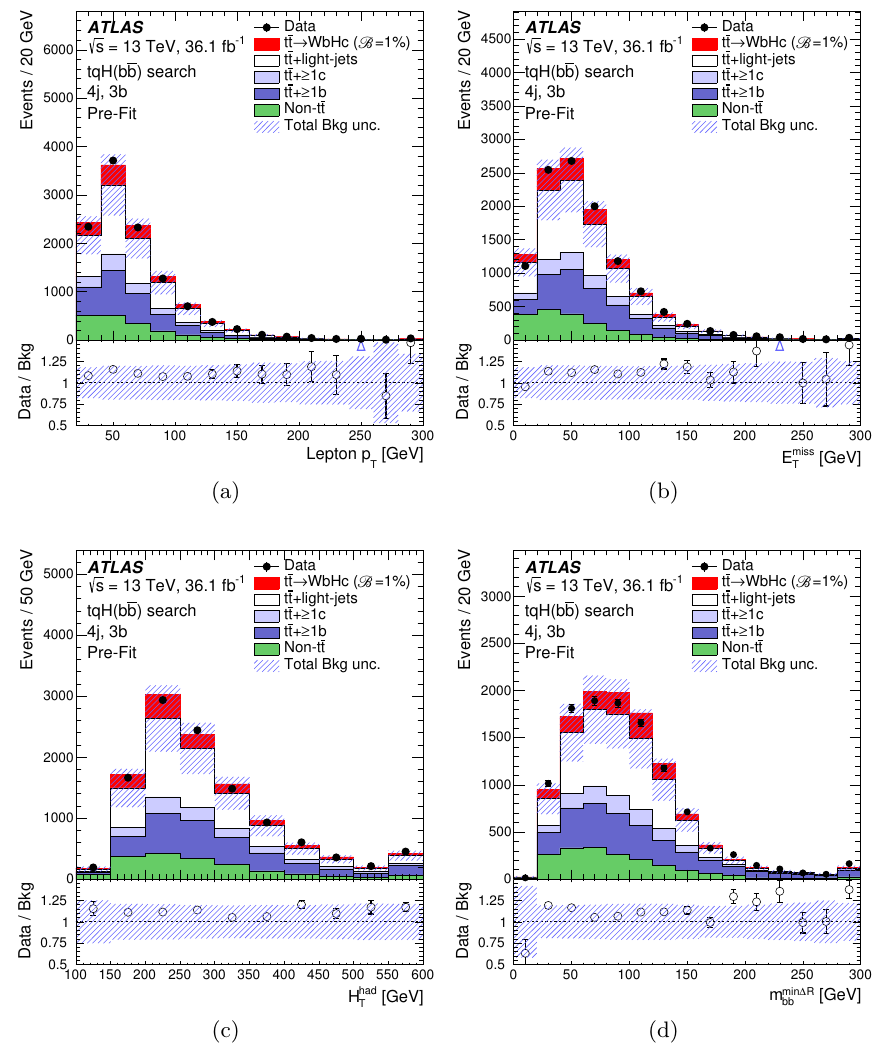
Figure 2 . tqH ( b (cid:22) b ) search: comparison between the data and predicted background after prese- lection for several kinematic distributions in the (4j, 3b) region before the (cid:12)t to data (\Pre-Fit"). The distributions are shown for (a) lepton p T , (b) E miss , (c) scalar sum of the transverse momenta T of the jets ( H had ), and (d) the invariant mass of the two b -tagged jets with lowest (cid:1) R separa- T tion ( m min(cid:1) R ). The small contributions from t (cid:22) tV , t (cid:22) tH , single-top-quark, W=Z +jets, diboson, and bb multijet backgrounds are combined into a single background source referred to as \Non- t (cid:22) t ". The expected t (cid:22) t ! WbHc signal (solid red) corresponding to B ( t ! Hc ) = 1% is also shown, added to the background prediction. The last bin in all (cid:12)gures contains the over(cid:13)ow. The bottom panel displays the ratio of data to the SM background (\Bkg") prediction. The blue triangles indicate points that are outside the vertical range of the (cid:12)gure. The hashed area represents the total un- certainty of the background, excluding the normalisation uncertainty of the t (cid:22) t + (cid:21) 1 b background, which is determined via a likelihood (cid:12)t to